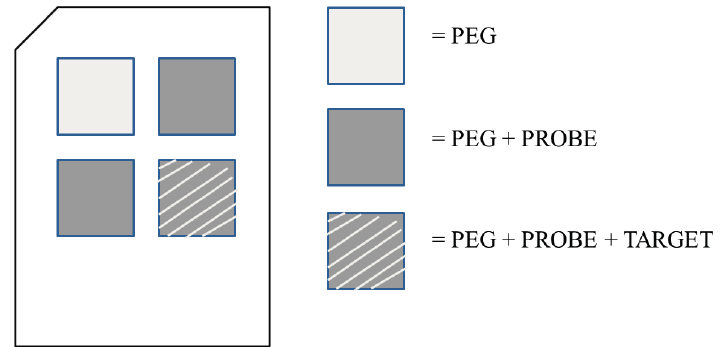
Figure 1. Schematic representation of the